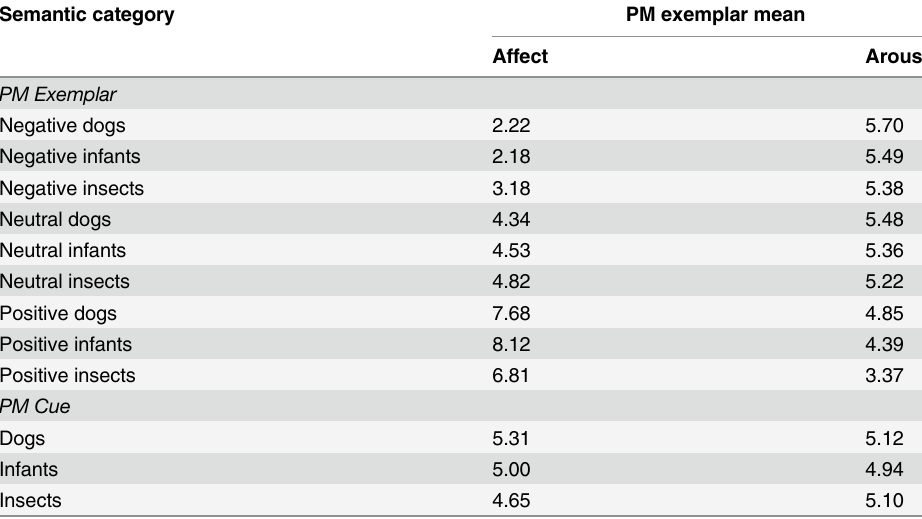
Table 2. Mean affect and arousal ratings of prospective memory exemplars and